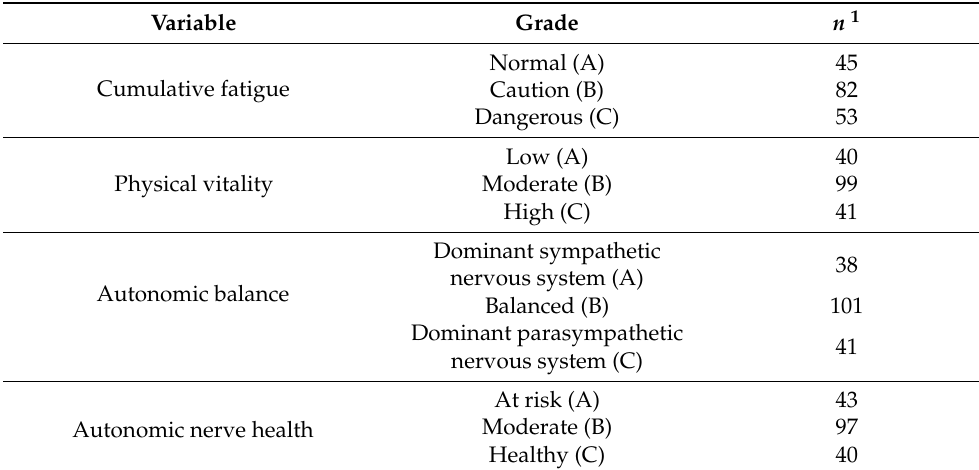
Table 3. Variables of the research subject classified by pulse wave